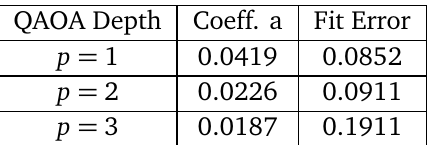
Table 1: Curve fit details for various QAOA depths from Figure 2 where the curve modeled is of the type: a × n b for b = 0.85. All numerical values are rounded to a precision of 4 decimal places.